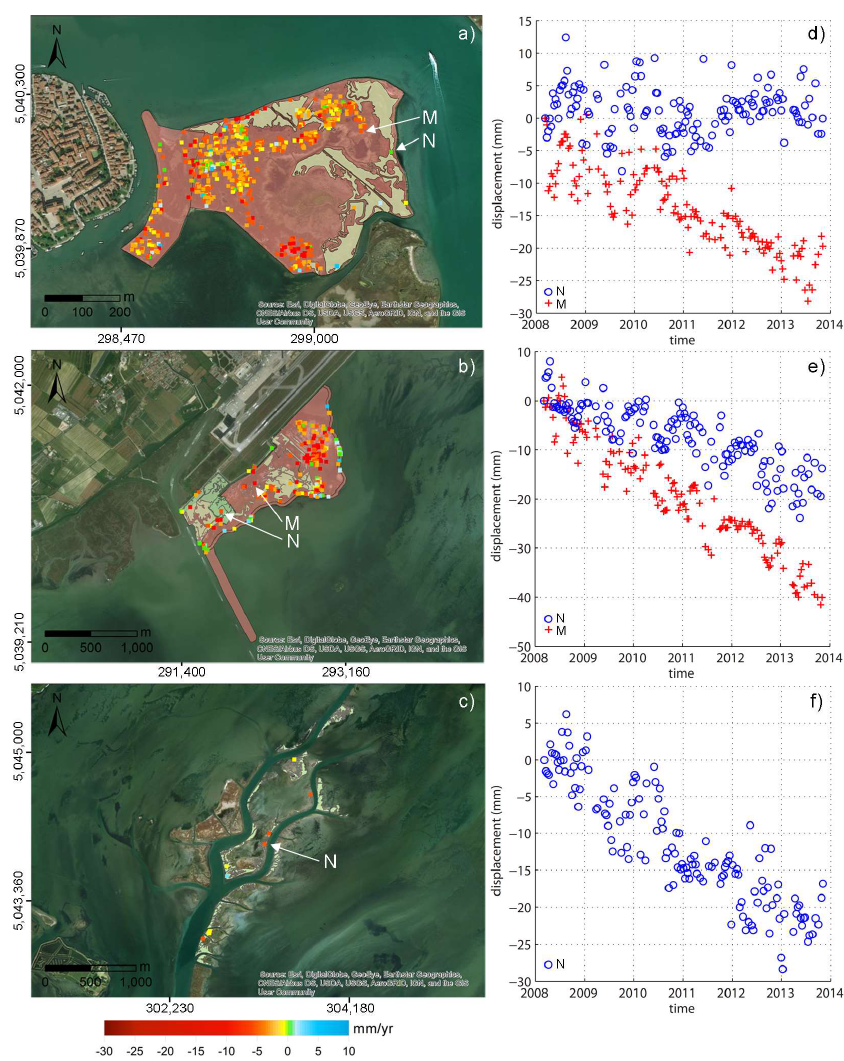
Figure 4. Examples of average land displacement over the years 2008–2013 (mm/year) detected by PSI on the salt marshes: ( a ) Burano; ( b ) Tessera; and ( c ) Cenesa. Salt marsh locations are indicated by white polygons in Figure 2. Positive values indicate uplift, while negative values indicate land subsidence. In ( a-c ) the natural portions of the salt marshes are shadowed in green, while man-made parts are shadowed in red. N and M refer to selected PTs on natural and man-made salt marsh, respectively, for which the displacement time series are provided in ( d – f ). Base map source: Esri, DigitalGlobe, GeoEye, Earthstar Geographics, CNES/Airbus DS, USDA, USGS, AEX, Getmapping, Aerogrid, IGN, IGP, swisstopo, and the GIS User Community.